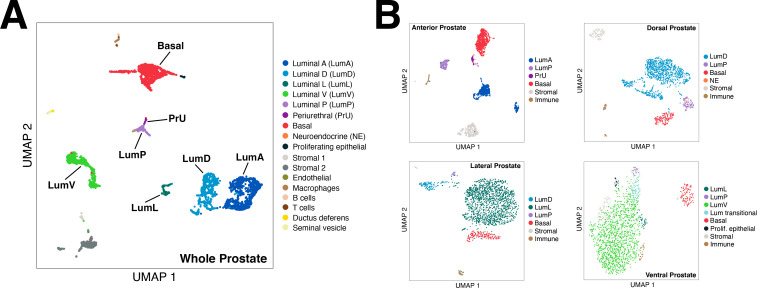
UMAP plots of mouse single-cell RNA-seq data.(A) UMAP plot of aggregated dataset of two normal mouse prostates; the dataset is the same as that shown in the tSNE plot in Figure 1A. (B) UMAP plots of datasets of individual mouse prostate lobes, corresponding to the tSNE plots in Figure 1B.